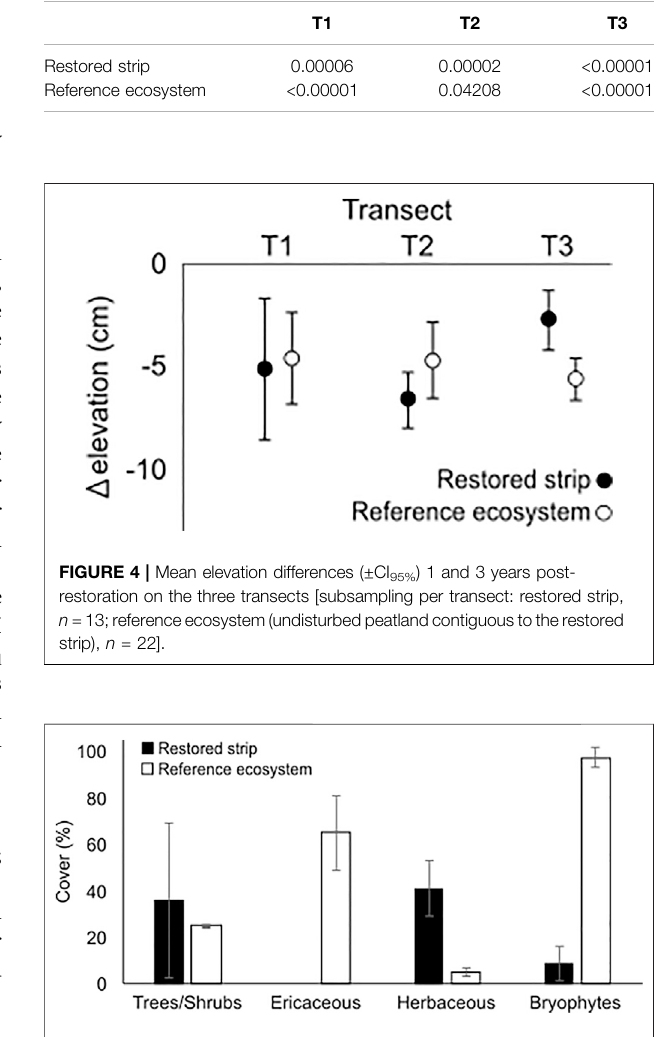
FIGURE5| Meantotalcoverofthemainvegetationstrata( ± CI 95% )three yearspost-restorationintherestoredstrip( n (cid:2) 8)andthereferenceecosystem (undisturbed peatland contiguous to the restored strip, n (cid:2)